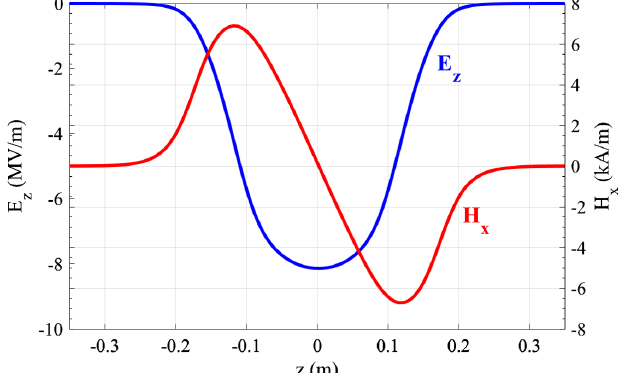
FIG. 3. Electric and magnetic field along the geometric center of a DQW cavity.